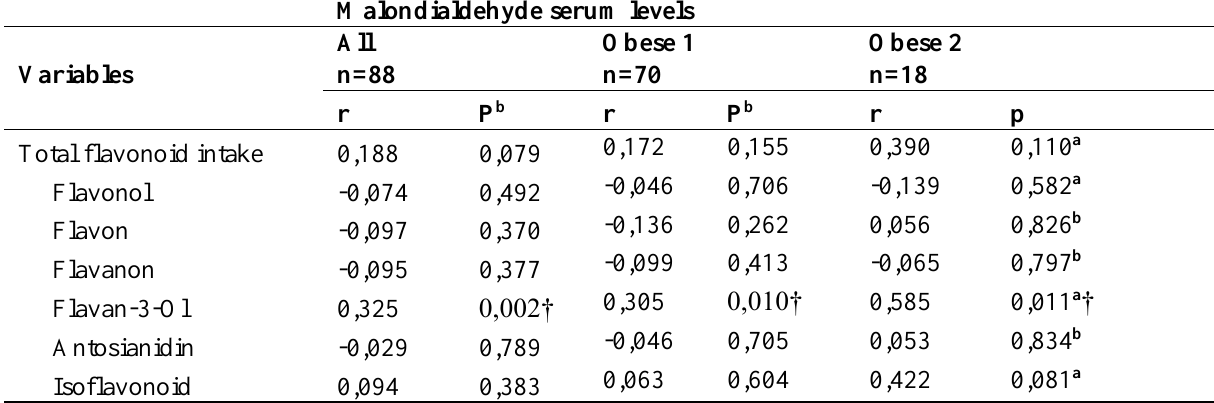
Table 4. Correlation between flavonoid intake and malondialdehyde serum level Malondialdehyde serum